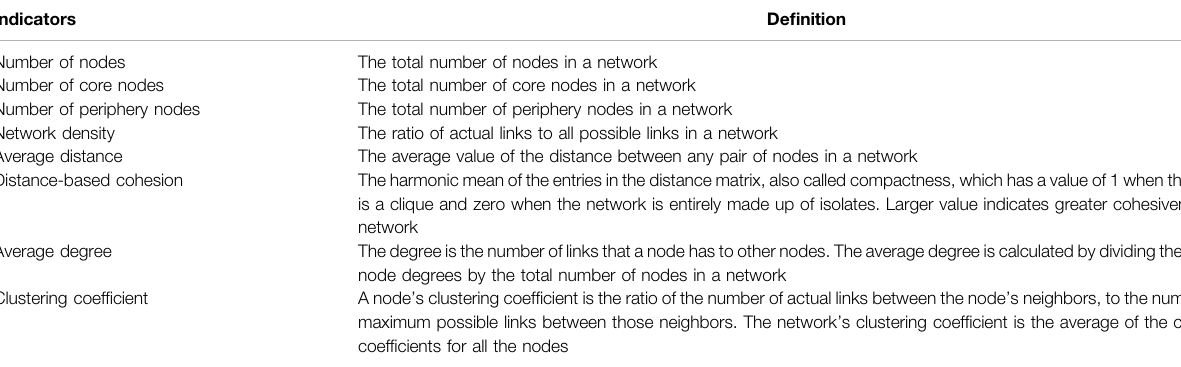
TABLE 3 | Indicators for network topological analysis. Indicators De fi nition Number of nodes The total number of nodes in a network Number of core